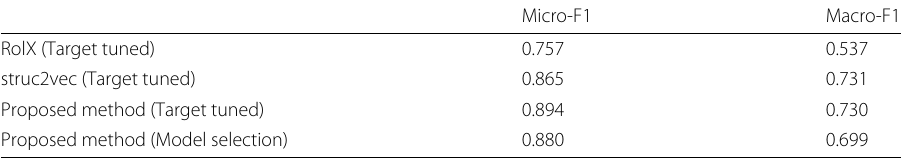
Table 1 Classification results on a toy